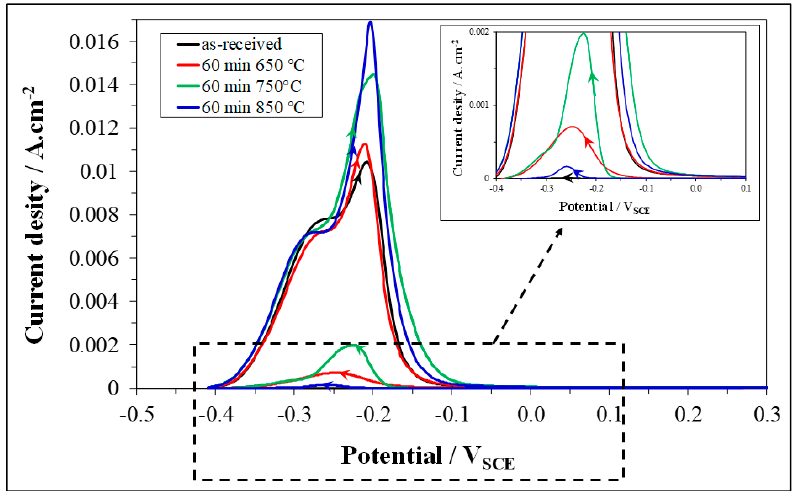
Figure 8. Current density vs. potential curves recorded on as-received and 60 min at 650, 750, and 850 °C aged LDSS 2404 electrodes, by DL-EPR tests in 33 wt.% H 2 SO 4 solution, with 0.9 wt.% HCl, at 20 °C.